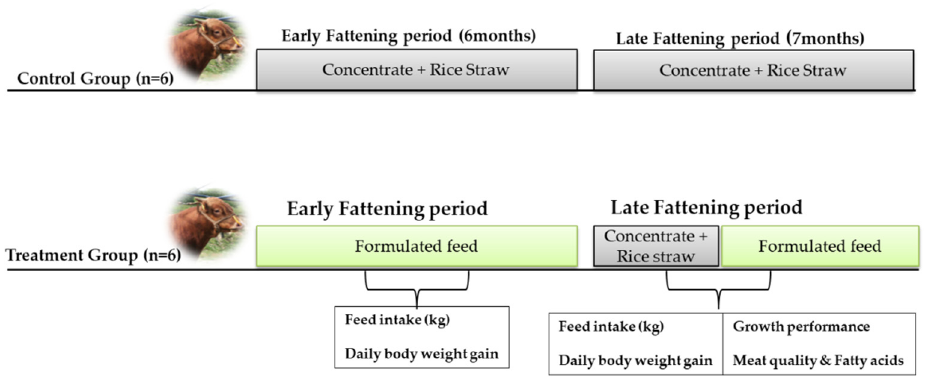
Figure 1. Experimental design and animal feeding system for concentrate and formulated feed.